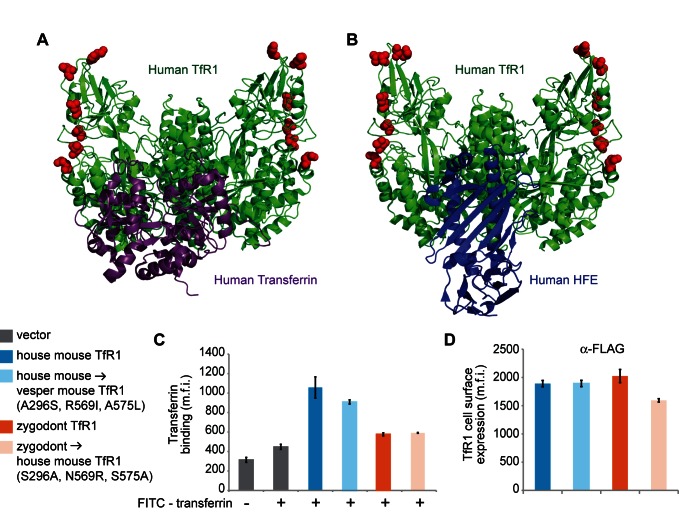
Mutations at sites of positive selection do not alter TfR1 association with host proteins.Co-crystal structures of human TfR1 in complex with (A) human transferrin (1SUV) [4] and (B) human HFE (1DE4) [2] illustrate that sites of positive selection (red) fall at a distance from these protein–protein interaction surfaces. Thus, mutations at these sites are not predicted to affect important host-beneficial functions of TfR1. MDCK cells stably expressing wild-type and mutant TfR1 were incubated with media containing FITC-labeled iron-loaded mouse transferrin. The cells were then washed and analyzed by flow cytometry for the mean fluorescent intensities (m.f.i.) of (C) FITC-transferrin and (D) a fluorescently labeled α-FLAG antibody measuring TfR1 surface expression. In all experiments, three replicates were performed and error bars indicate one standard deviation.